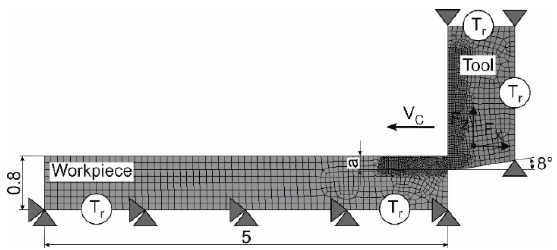
Figure 4. Initial geometry, boundary conditions, and mesh of the FE cutting model.